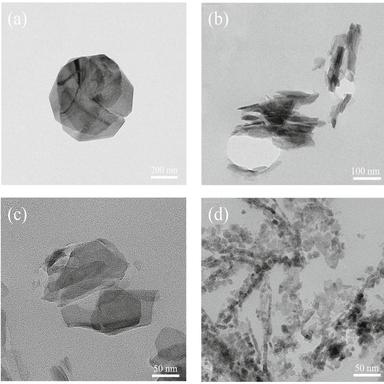
TEM images of (a) Cu-IM, (b) Co-MOF, (c) Cu-IM/Co-MOF, (d) Cu-IM/Co-MOF 250.